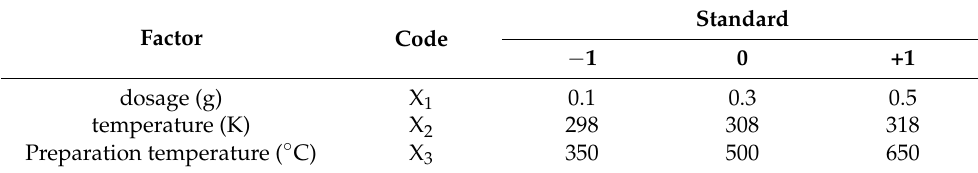
Table 4. Coding and level values of experimental factors.